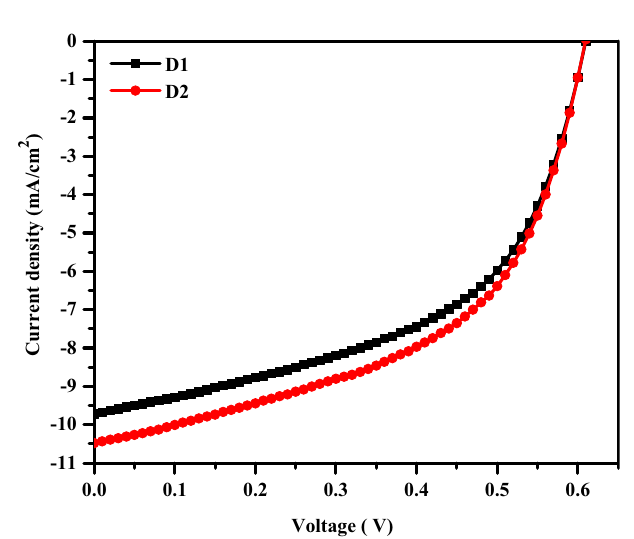
Figure 8. J–V characteristics curves of fabricated devices under AM 1.5